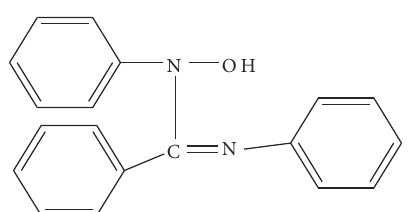
Figure 1: Structure of N 1 -hydroxy-N 1 ,N 2 -diphenylbenzamidine